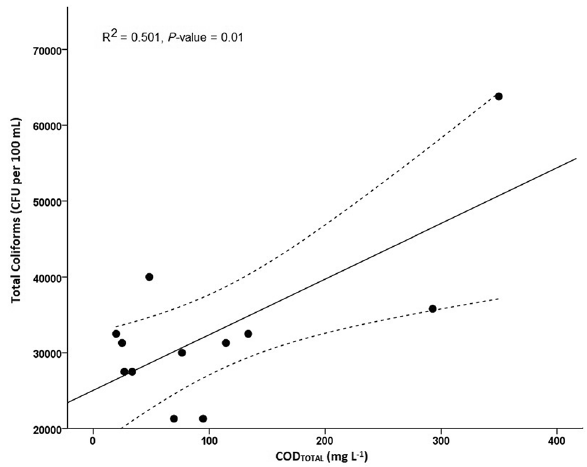
Figure 3. Linear logistic regression between total coliforms and COD TOTAL (R 2 = 0.501, P -value = 0.010; N = 12). Legend: Upper and lower 95% Confident Interval (95% CI) limit in the linear logistic regression (-—-).